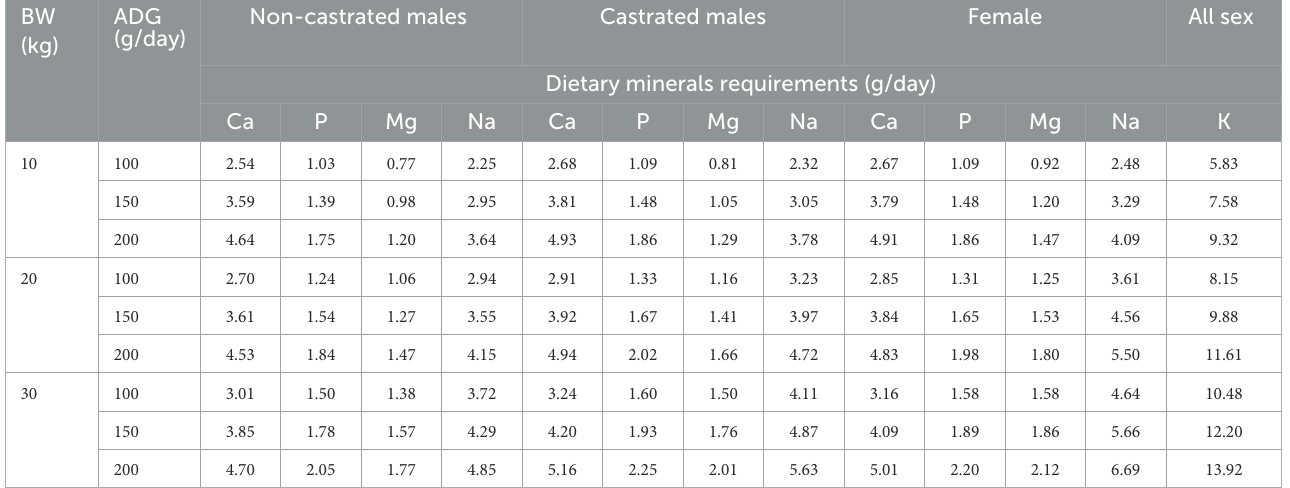
TABLE 8 Dietary mineral requirements for hair